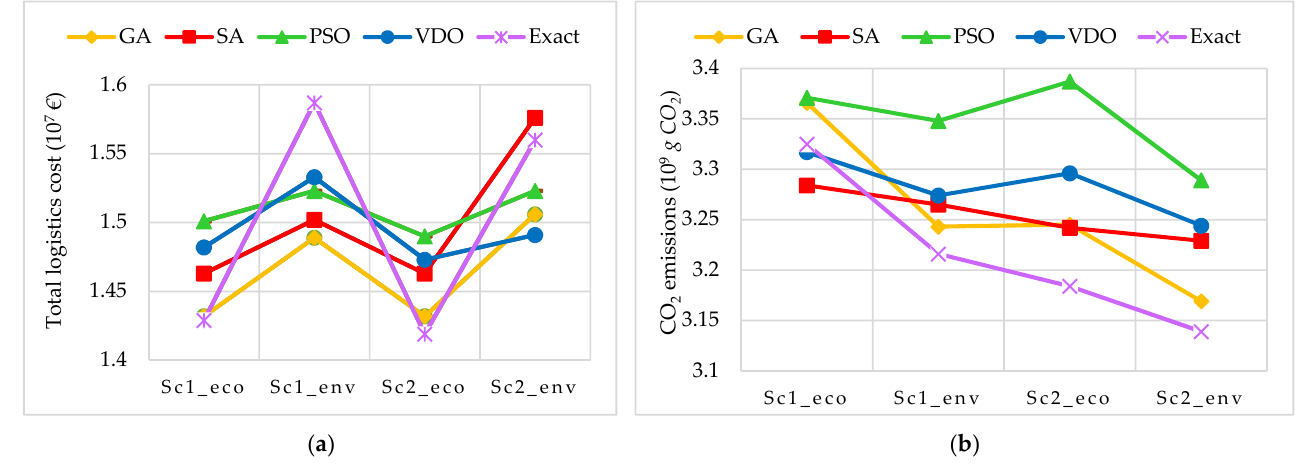
Figure 11. Results of the different scenarios. ( a ) Economic results; ( b ) Environmental results. The results of the social/societal aspect of sustainability are represented in Figure 12. The distribution of goods via the Sc1_eco scenario generated the lowest accident rate and the lowest fatal accident rate. In addition, the Sc1_env scenario showed the best noise re- sults, compared to the other scenarios. Therefore, from a social/societal point of view, Sc1 scenario is the best.